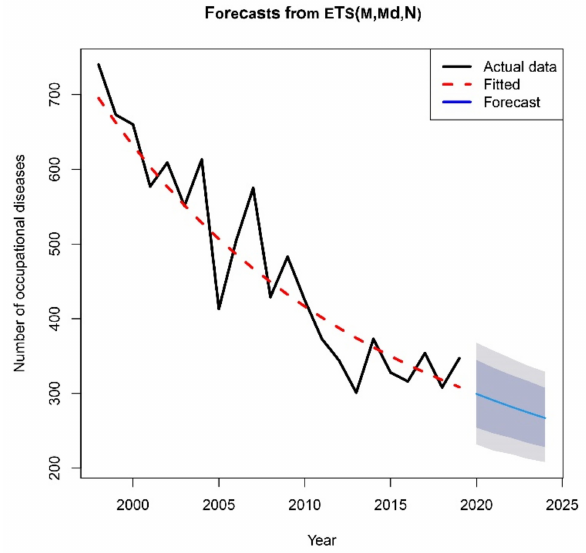
Figure 11. Development and forecast of the number of occupational diseases [Output: R].